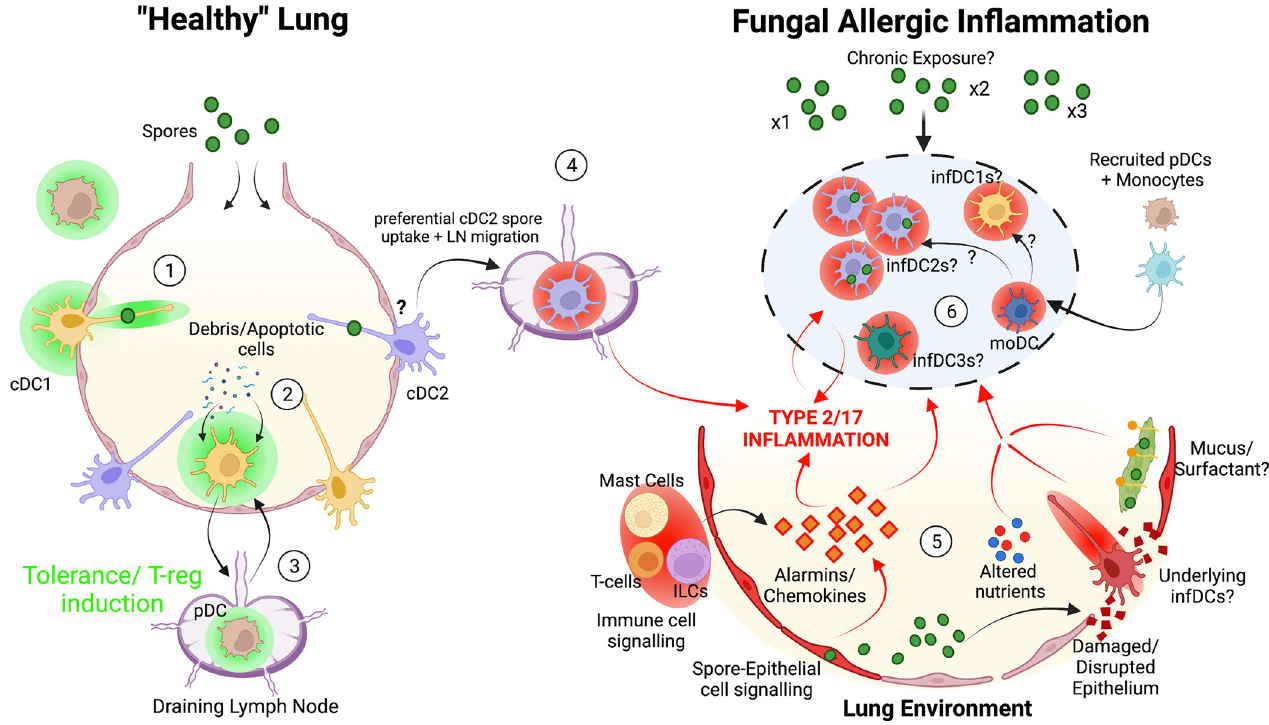
Fig 2. Understanding how DC induction of fungal allergic inflammation is shaped by the lung environment. In health ( left ), DCs predominantly reside in the tissue but can project dendrites into the airway to sample antigen. ( 1 ) As AlvM F s predominantly clear inhaled spores [43], exposure of DCs to fungal antigen is minimal reducing potential for inflammatory responses. ( 2 ) DC subsets, especially cDC1s, assume housekeeping duties (e.g., clearance of apoptotic cells) maintaining a tolerogenic phenotype. ( 3 ) Upon migration to draining LN lung DCs, in concert with other subsets such as pDCs, induce T-reg generation further maintaining an immuno-regulatory lung environment. ( 4 ) Fungal allergic inflammation is initiated upon cDC2 acquisition of Af spores and migration to the draining LN where they can prime adaptive CD4 + T cell responses ( right ). ( 5 ) While the precise mechanisms by which cDC2 mediate these responses to spores is unclear, the lung environment is known to directly influence this process. Fungal secretory products (including proteases) in the airway lumen can not only activate DCs directly, but also damage the epithelial barrier. This allows spores to move beyond the epithelial barrier and potentially activate cDC2s in the deeper underlying tissue. Furthermore, epithelial cell responses to fungi and/or barrier damage triggers the release of alarmins, chemokines, cytokines, and DAMPs (e.g., CCL2, IL-6, IL-33, and TSLP 173, [174,175]), which can further activate DCs to promote allergic response. In addition, ILCs and mast cells (which can be activated by epithelial signals) further promote type 2 and type 17 cytokine which further conditions DCs to exacerbate allergic inflammation [68,145,180,184]. Other lung environmental factors such as altered nutrient availability and increased surfactant/ mucus concentrations [45,158] can further shape DC responses. ( 6 ) These features can lead to the formation of several inflammatory DC states (infDC1, infDC2, and infDC3) and possibly DCs differentiated from monocytes (moDCs) which further amplify and sustain fungal allergic inflammatory disease. Figures were created with BioRender.com. AlvM F , alveolar macrophage; CCL, chemokine ligand; DC, dendritic cell; IL, interleukin; moDC, monocyte-derived dendritic cell TSLP, thymic stromal